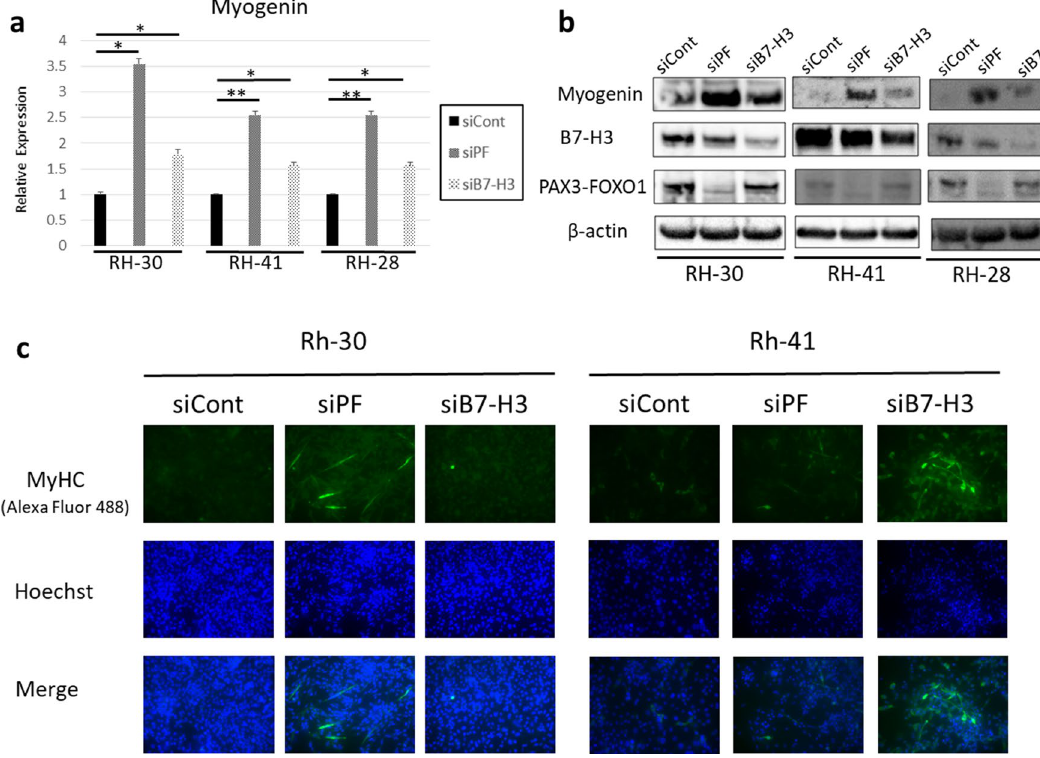
Figure 6. Knockdown of PAX3-FOXO1 and B7-H3 induces the expression of myogenin and may induce myoblast differentiation. ( a ) Quantitative real-time PCR analysis of myogenin . ( b ) Western blot analysis of myogenin. Knockdown of PAX3-FOXO1 (detected by anti-PAX3 antibody) and B7-H3 induces the expression of myogenin. ( c ) Immunofluorescence of myosin heavy chain. Results shown represent means ± SD. * p < 0.05, ** p < 0.01, by two-tailed unpaired t